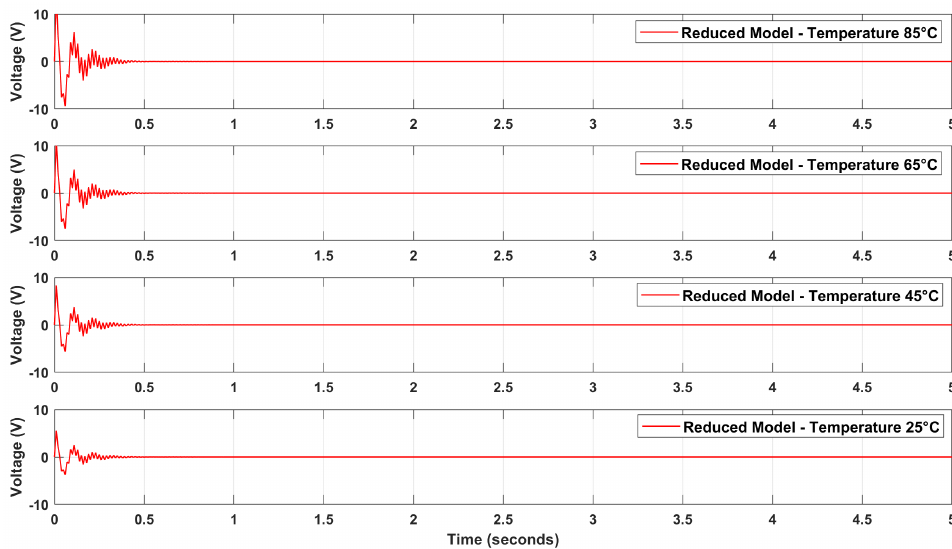
Figure 11. Sensor output voltage using LQG-Kalman control in reduced model for multiple tempera- tures with 5 distributed pairs of sensor/actuator and 10 selected sensor nodes.